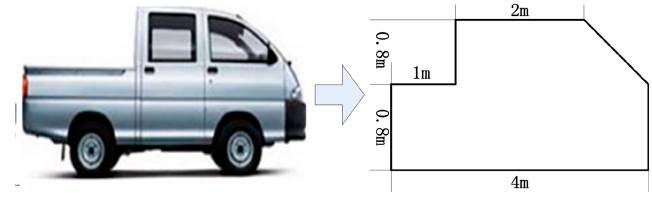
Figure 12. Simplified ground vehicle model. Table 2. Simulation parameters of vehicle model.